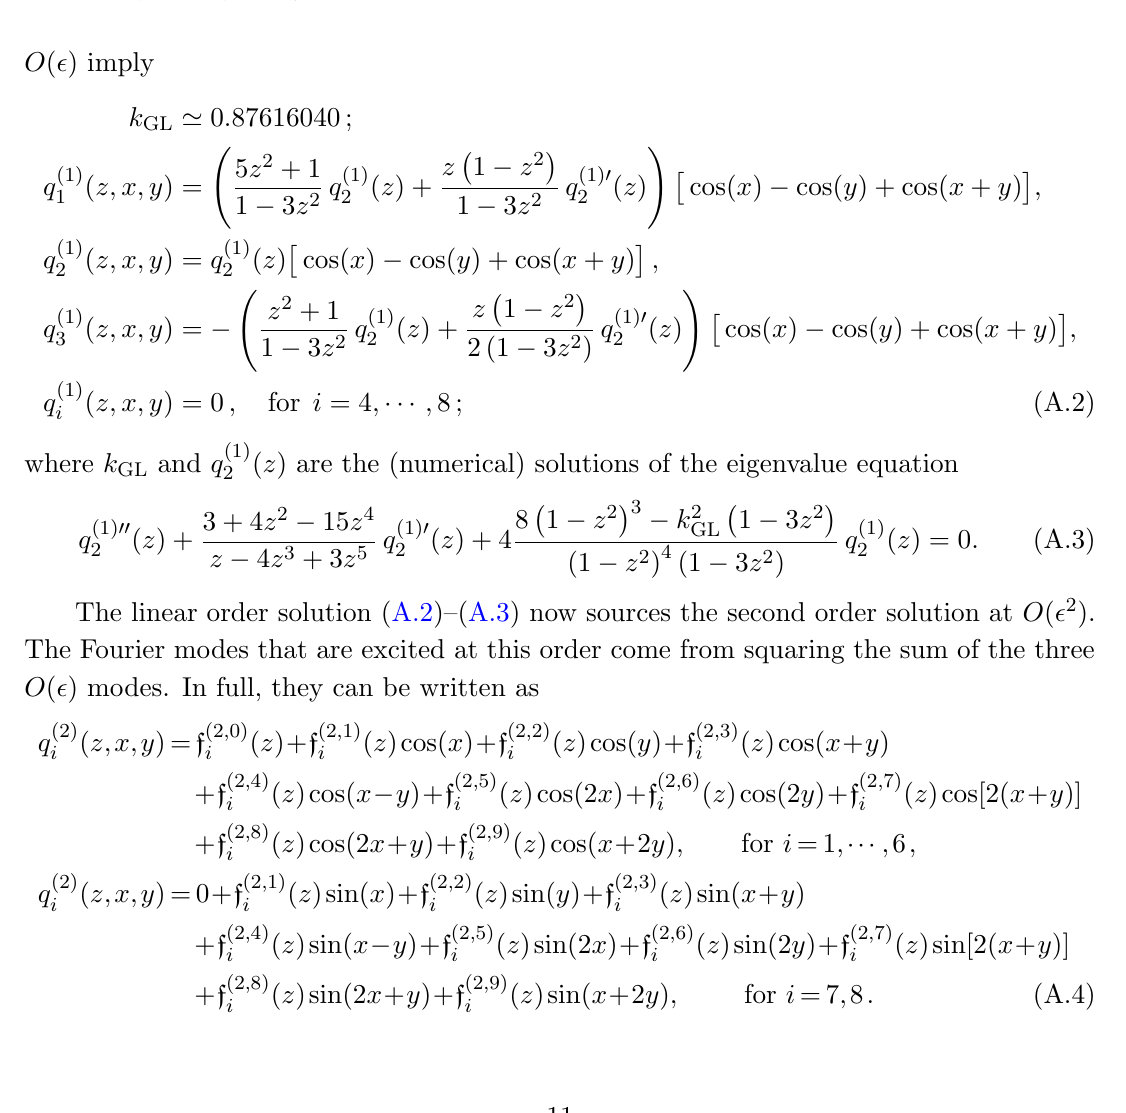
Figure 4 . Structure of triangular and hexagonal nonuniform black branes ( (cid:13) = 1 = 2, (cid:15) = (cid:6) 10 (cid:0) 2 ). Radius of the S 2 at the horizon (which is proportional to the square root of the entropy density) as a function of the lattice directions x 1 and x 2 for the black brane with triangular (left) and hexagonal (right) arrangements. The lighter yellow regions represent the locations of the lattice points where the entropy density is